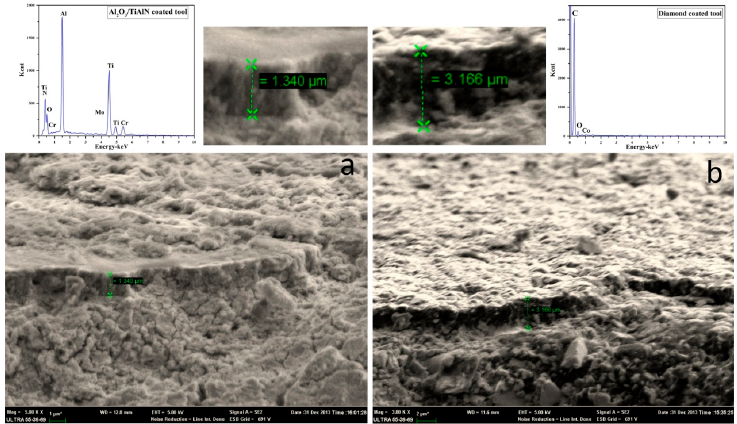
Figure 1. SEM micrographs and EDS analysis of the coating surfaces (( a ) PVD (Al 2 O 3 /TiAlN)-coated insert; ( b ) CVD diamond-coated insert).